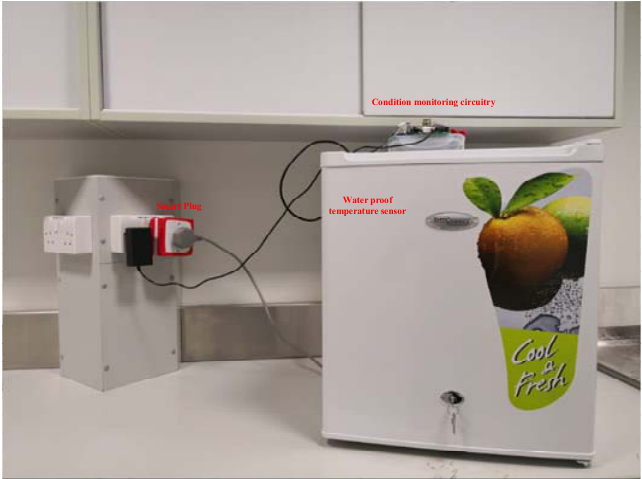
Figure 9. Experimental setup of the refrigerator.